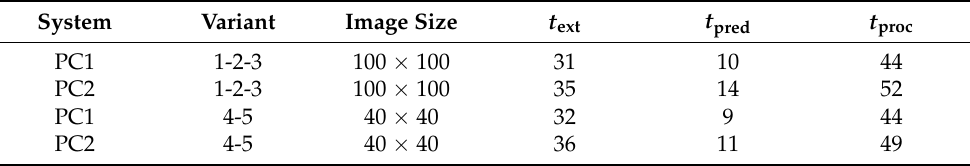
The meaning of the symbols used in Table 5 is as follows: t ext —average ROI extraction time; t pred —average time of the co-firing variant prediction; t proc —average overall frame processing time. Average values were calculated as a result of processing a video sequence consisting of 600 frames (100 × 100 pixels) for multiclass model and 400 frames (40 × 40 pixels) for binary model. All the measured times are expressed in